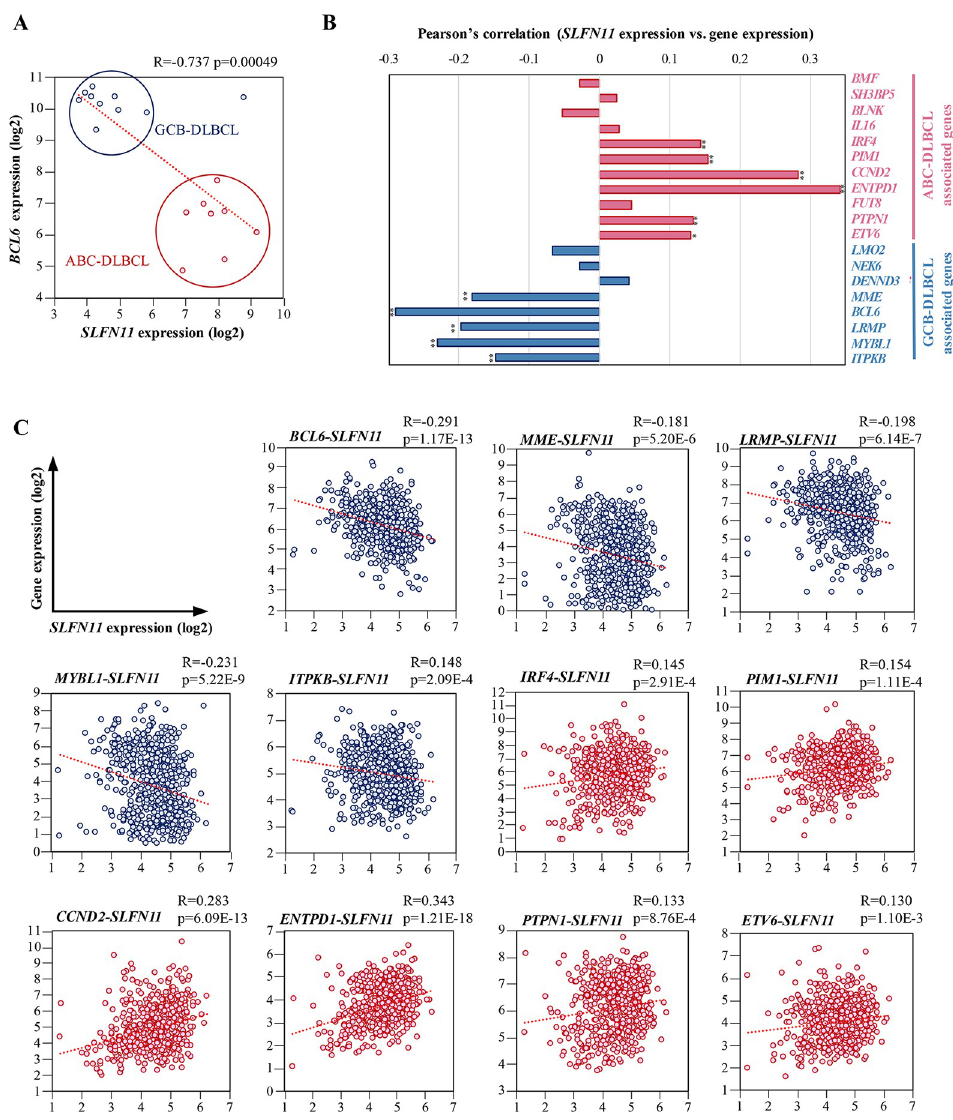
Fig 3. Correlation of the expression of SLFN11 and ABC- and GCB-DLBCL-associated genes in human DLBCL. (A) mRNA expression of BCL6 and SLFN11 . X-axis represents SLFN11 mRNA expression (log2). Y-axis represents BCL6 mRNA expression (log2). The red dots are ABC-DLBCL cell lines and the blue dots are GCB-DLBCL cell lines. Pearson’s correlation (R), P-value (p) and regression line (red dotted line) are shown. GCB-DLBCL, germinal center B- cell like-diffuse large B cell lymphoma; ABC-DLBCL, activated B-cell like-diffuse large B-cell lymphoma. (B) Pearson’s correlation of SLFN11 expression level with DLBCL subtypes genes. ABC-DLBCL-associated genes consist of 11 genes ( BMF , SH3BP5 , BLNK , IL16 , IRF4 , PIM1 , CCND2 , ENTPD1 , FUT8 , PTPN1 , ETV6 ). GCB-DLBCL-associated genes consist of 8 genes ( LMO2 , NEK6 , DENND3 , MME , BCL6 , LRMP , MYBL1 , ITPKB ). � p < 0.01, �� p < 0.001. (C) mRNA expression of DLBCL subtype genes and SLFN11 . X-axis represents SLFN11 mRNA expression (log2). Y-axis represents mRNA expression (log2) for genes associated with DLBCL subtypes. Pearson’s correlation (R), P-value (p) and regression line (red dotted line) are